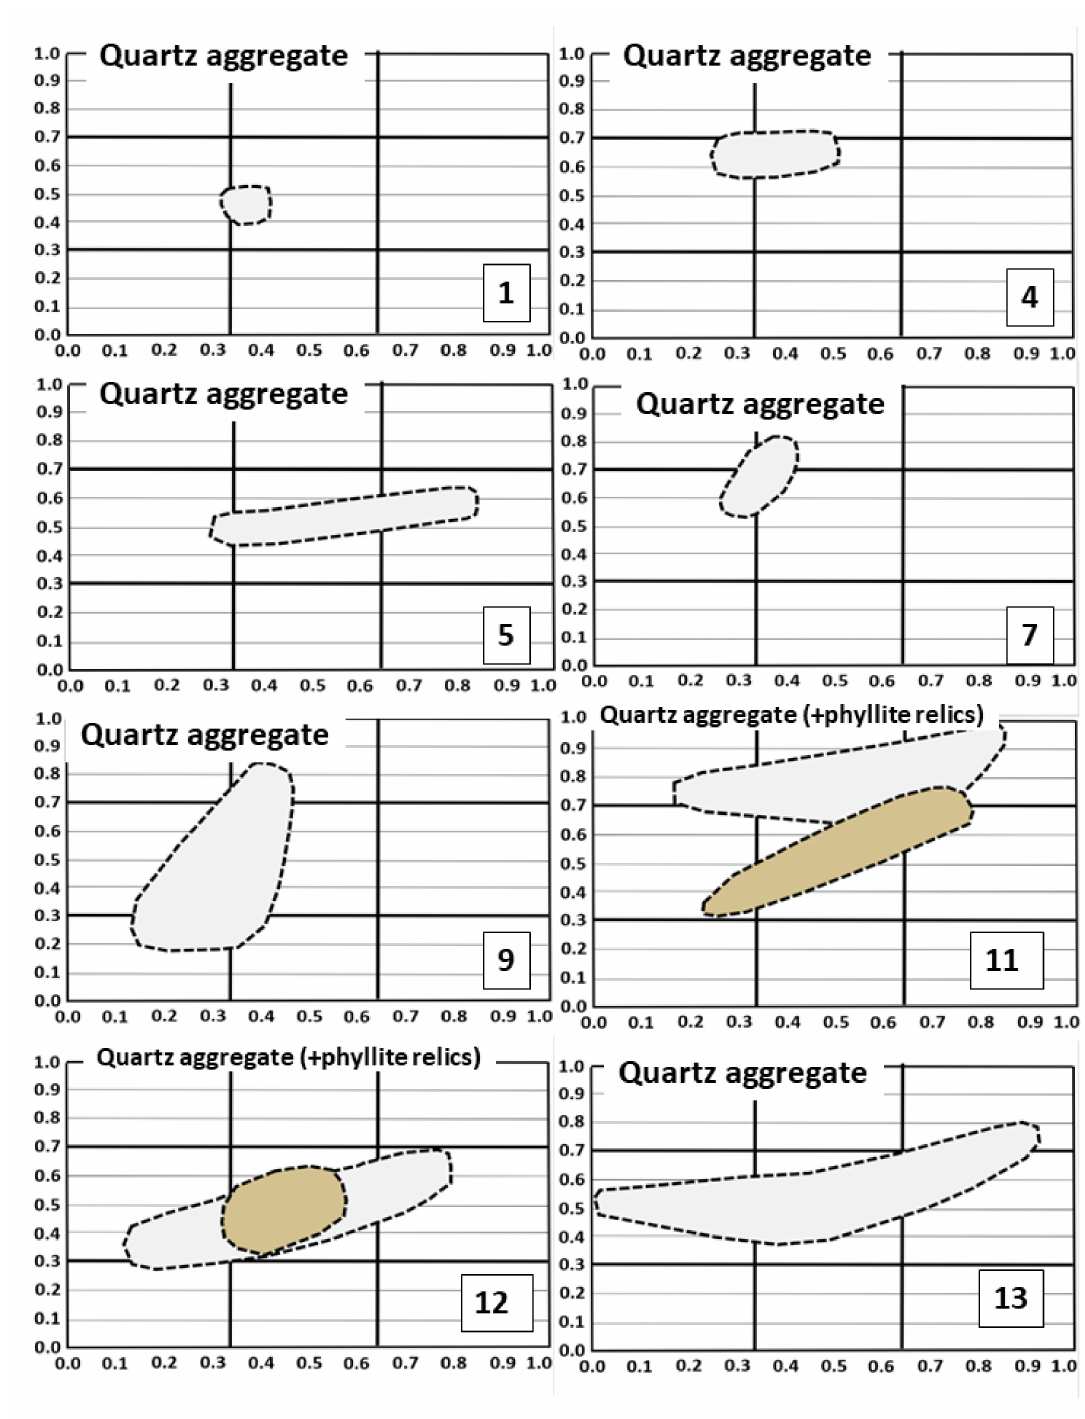
Figure 8. Grain morphology of quartz aggregates as a function of the distance to source given by the site number. See also geological base map of Figure 3. In the x-y plot of sites 11 and 12, quartz clasts bearing phyllitic remnants in notches and voids are illustrated. Therefore, the gravel-sized phyllites are on display for